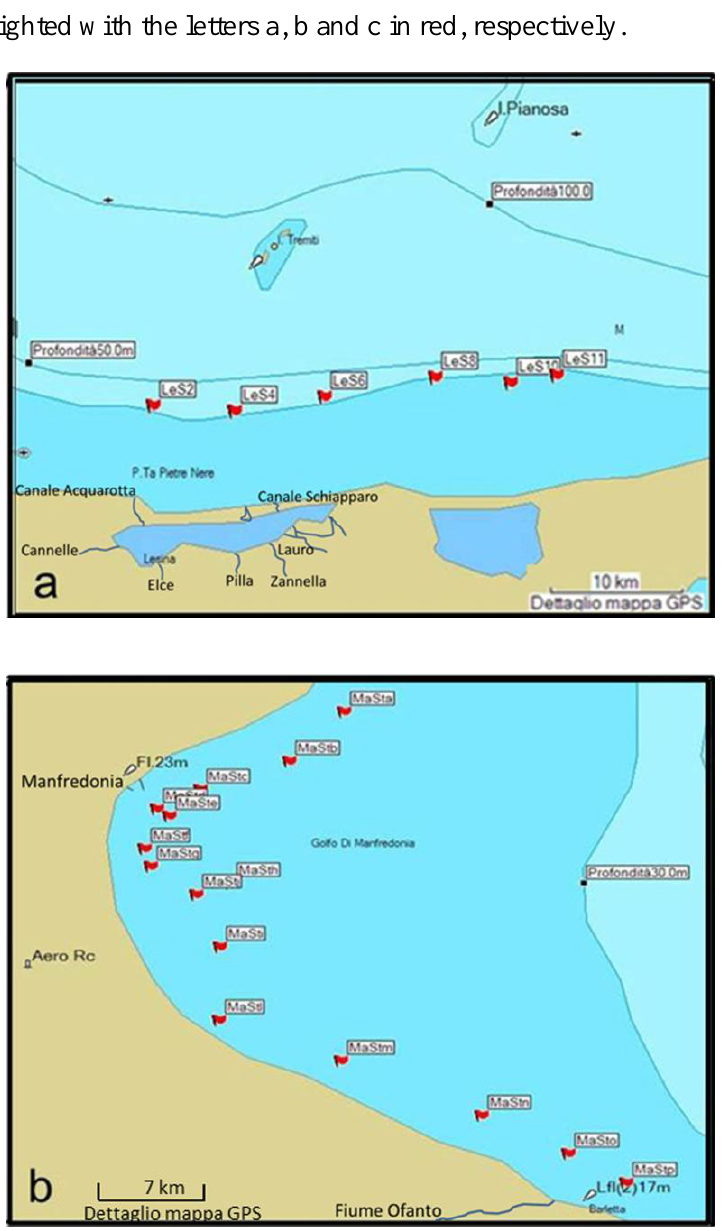
Figure 1. The station locations of the three study areas are shown on the bathymetry maps: ( a ) station names and locations of the coastal waters close to the Lagoon of Lesina; ( b ) station names and locations of the coastal waters of the Gulf of Manfredonia; ( c ) station names and locations of the coastal waters of the Gulf of Taranto; ( d ) location of the coastal waters close to the Lagoon of Lesina, the Gulf of Manfredonia and the Gulf of Taranto, which are highlighted with the letters a, b and c in red,